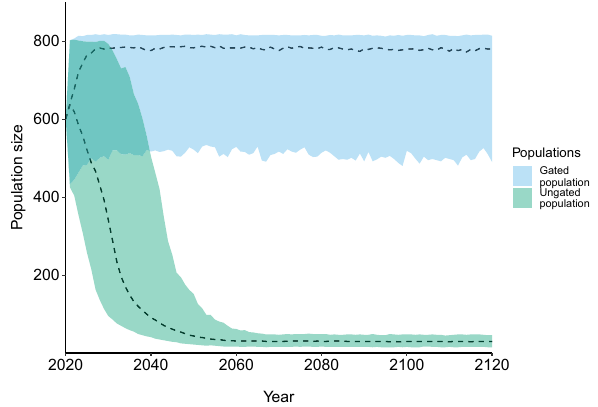
Figure 4. Population viability analysis for broad-headed snakes in Morton National Park, New South Wales, Australia. This figure represents simulated population trajectories where survival estimates for the gated population was assumed for both populations, but a harvesting rate of 22 females per year was imposed on the ungated population. All other life history parameters were maintained. The ungated population (green) is only saved from local extinction by dispersal of juveniles from the gated